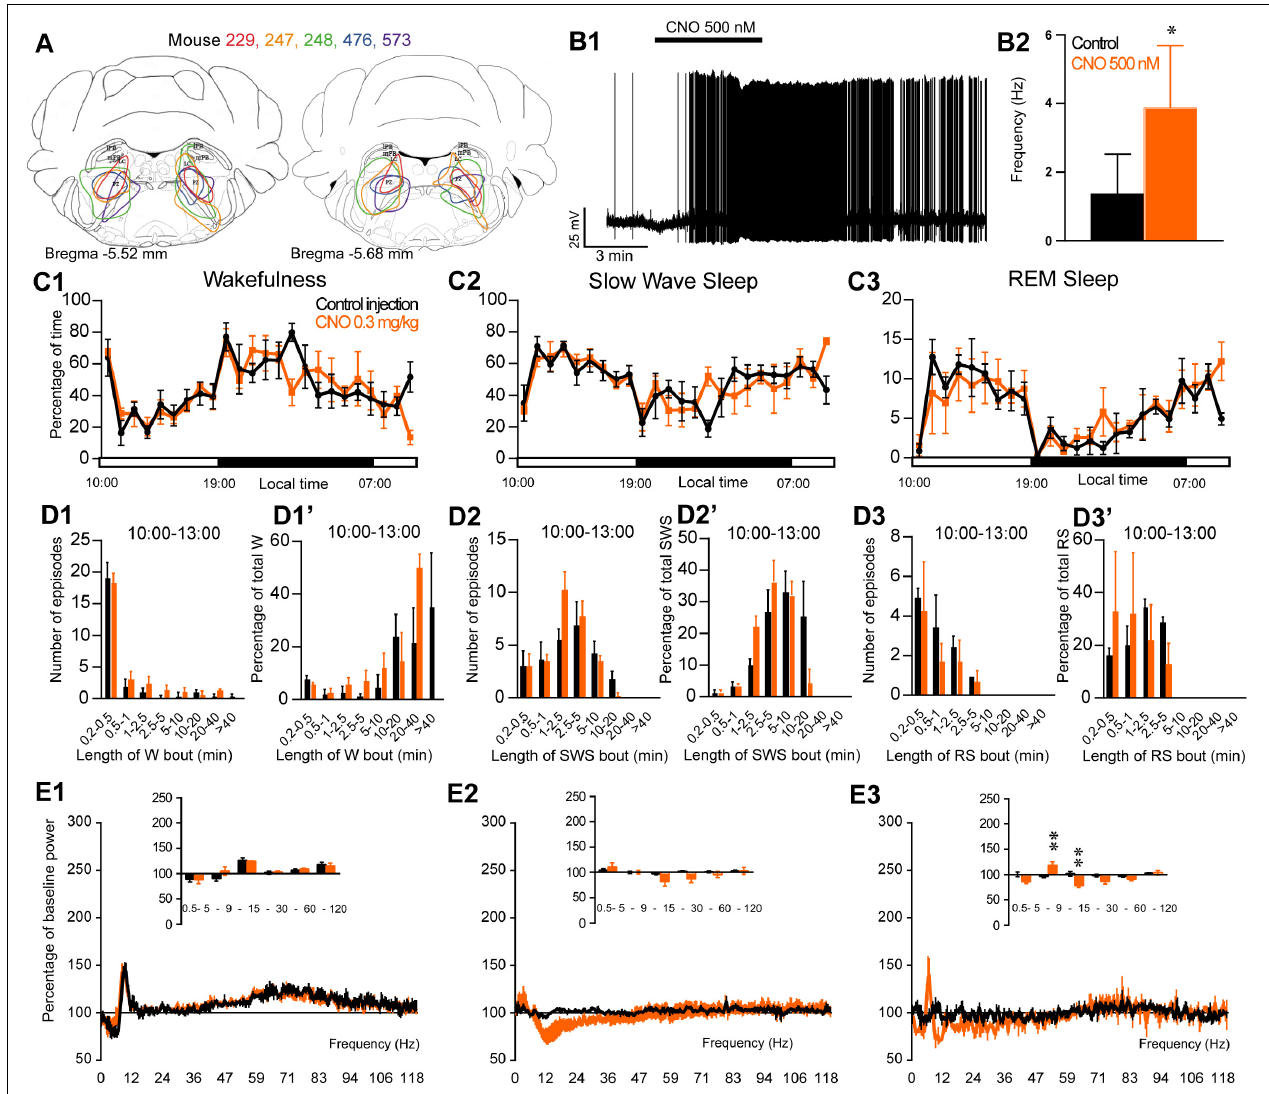
FIGURE 7 | Activation of PZ Phox2B-expressing neurons during the inactive period (10:00 or ZT3). (A) Extent of transduced neurons (mCherry-positive somas) is shown for individual Phox2B-IRES-cre mice that received bilateral injections of hM3Dq-mCherry-AAV into the PZ (PZ Phox2B − hM3Dq ). (B1) PZ Phox2B − hM3Dq whole-cell recording showing an increase in firing frequency in response to bath application of CNO (0.5 µ M). (B2) Average firing frequency ( ± S.E.M.) during the last 2 min of CNO (0.5 µ M) application as compared with the 2 min period preceding CNO application (control; N = 5 PZ Phox2B − hM3Dq neurons). ∗ p < 0.05 Paired Student’s t -tests. (C) Hourly amount of wakefulness (C1) , SWS (C2) and REM sleep (C3) following CNO (0.3 mg/kg, 10 A.M., N = 4 mice) as compared with control injection. (D1–D3) Number of episodes ( ± S.E.M.) of wakefulness (W), SWS, or REM sleep (RS) in each bout length and (D1’–D3’) time-weighted frequency histograms showing the proportion ( ± S.E.M.) of W, SWS or RS amounts in each bout length as a percentage of the total amount of W, SWS or RS during the 3 h post-injection period (10:00–19:00; N = 4). (E1–E3) Sleep-wake power spectrum changes over baseline during the 3 h (10:00–13:00) post CNO (0.3 mg/kg, N = 4 mice) injection as compared with control injection; and the quantitative changes ( ± S.E.M.) in power for the δ (0.4–5 Hz), θ (5–9 Hz), α (9–15 Hz), β (15–30 Hz), low γ (30–60 Hz) and high γ (60–120 Hz) frequency bands ( ± S.E.M.) following vehicle or CNO (0.3 mg/kg, N = 4 mice) administrations. (C–E) Control injection in Black, CNO injection in orange; ∗∗ p < 0.01, two-way ANOVA followed by a post hoc Bonferroni test.